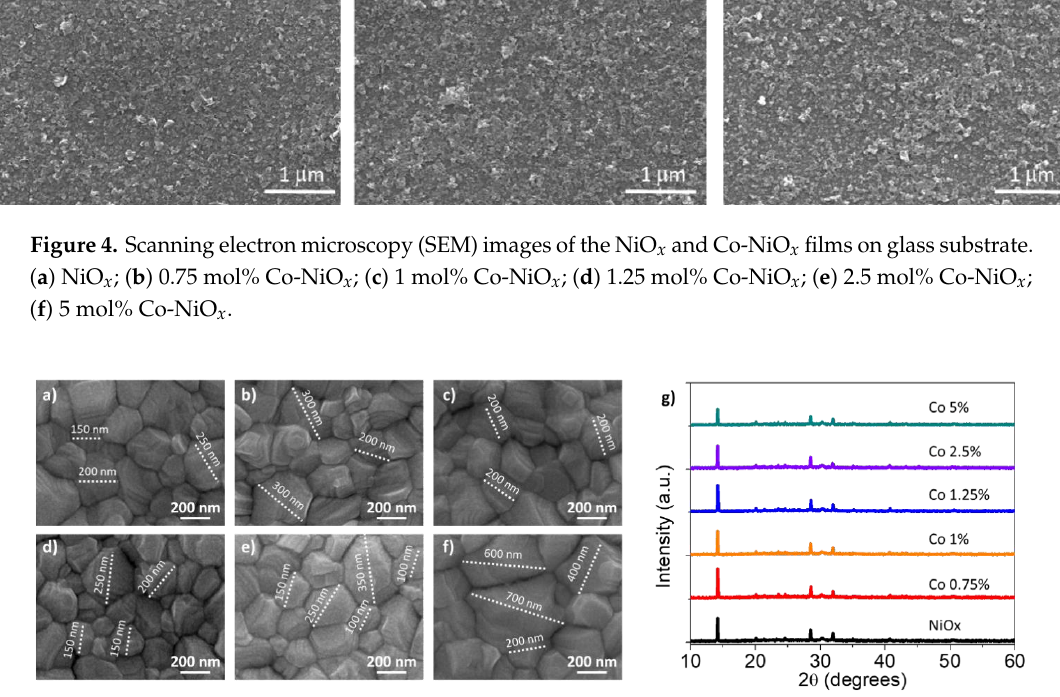
Figure 5. Top view SEM images for perovskite layers fabricated on the top of NiO x or Co-NiO x layer; ( a ) NiO x . ( b ) 0.75 mol% Co-NiO x ; ( c ) 1 mol% Co-NiO x ; ( d ) 1.25 mol% Co-NiO x ; ( e ) 2.5 mol% Co-NiO x ; ( f ) 5 mol% Co-NiO x ; ( g ) corresponding perovskite X-ray diffraction patterns.